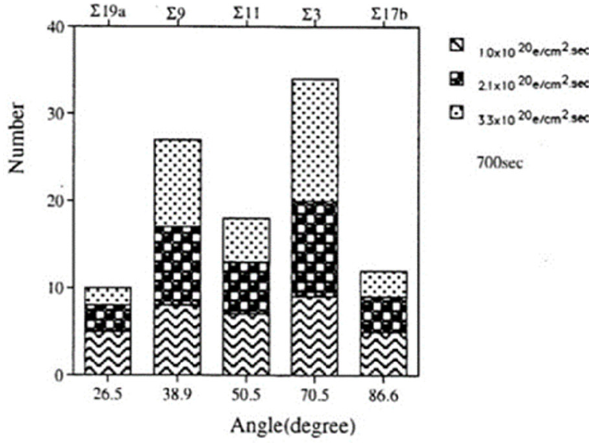
Figure 25. Histogram of tilt boundaries under electron irradiation at three intensities from 1.0 to 3.3 × 10 20 e/cm 2 s for 700 s. Σ3 CSL boundaries were predominant as a low energy structure [19].